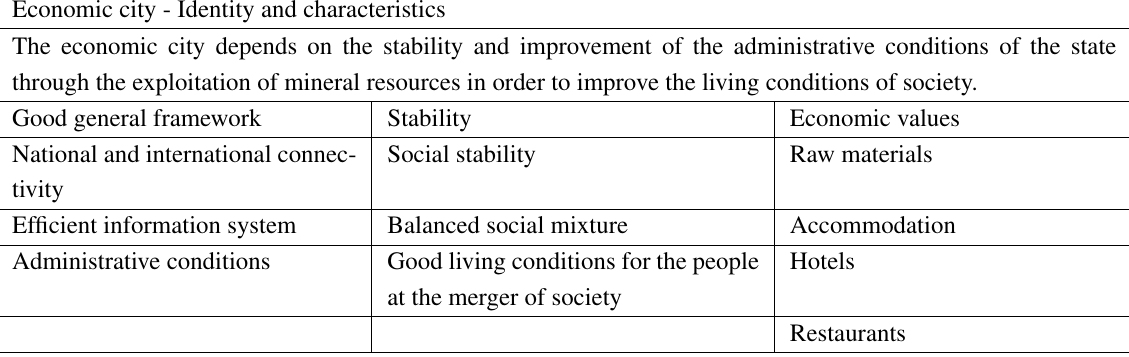
Table 9. Economic city - Identity and